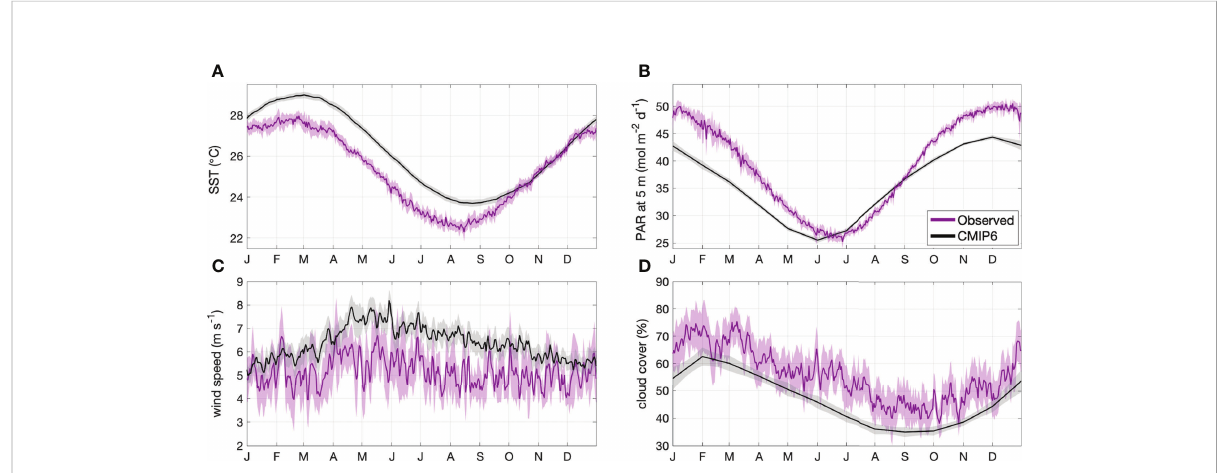
FIGURE 2 Area-averaged climatology ± 2 SE (shaded area) of contemporary (2001-2020) (A) SST, (B) PAR at 5 m, (C) wind speed and (D) cloud cover for the GBRMP. Climatologies are calculated from MODIS or ERA-5 reanalysis data (magenta) and CMIP6 model output